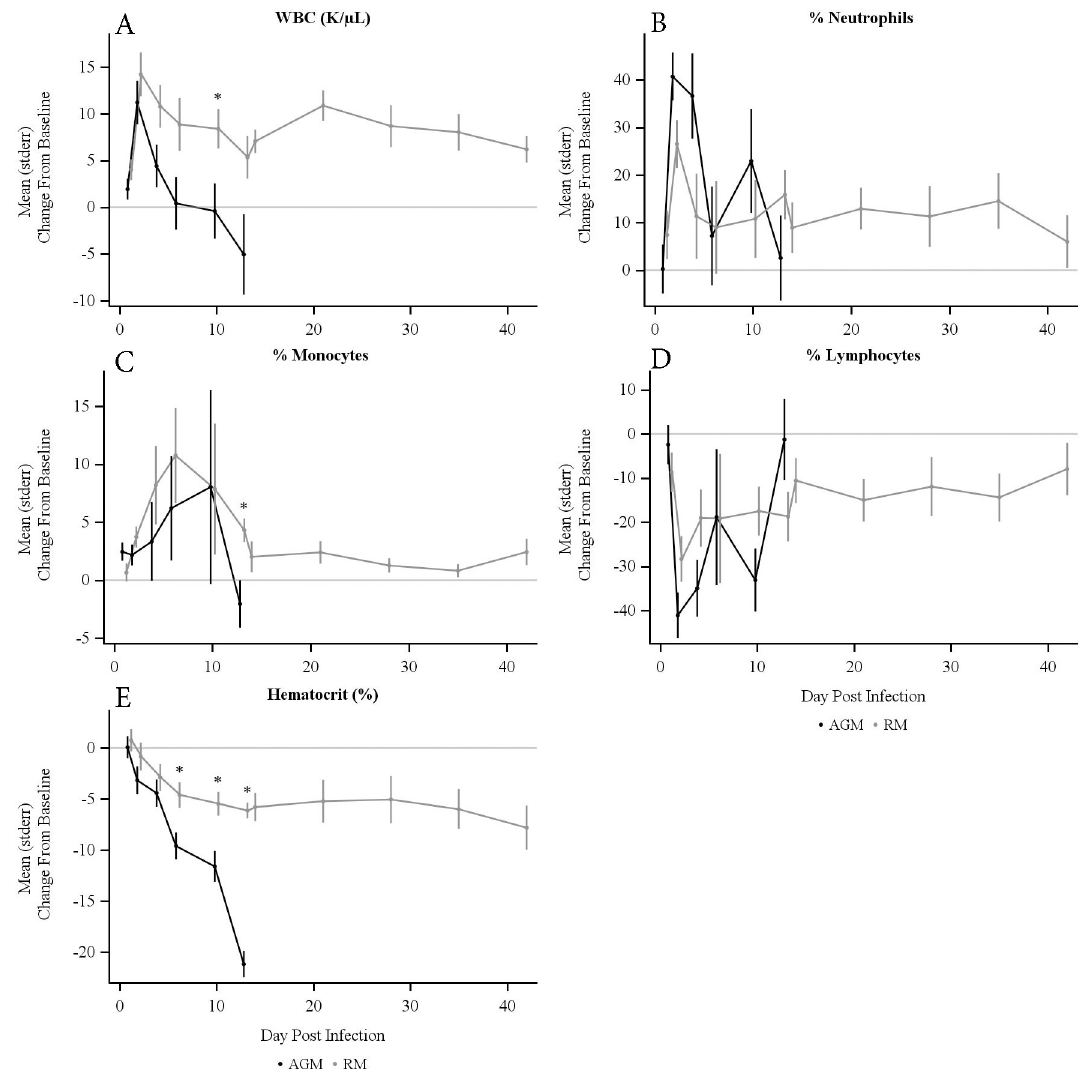
Fig 4. Changes from baseline in (A) white blood cell counts (WBC), (B) neutrophils, (C) monocytes, (D) lymphocytes, and (E) hematocrit over time in AGMs and RMs exposed to aerosolized B . pseudomallei HBPUB10134a. � denotes statistically significant difference between AGM and RM groups by t -test ( p < 0.05). Points indicate mean, with error bars extending to one SEM. Significant differences were found in (A) WBC, (C) % Monocytes, and (E) % Hematocrit from days 7 to 13 PI. Neither (B) % Neutrophils nor (D) % Lymphocytes showed significant differences between the